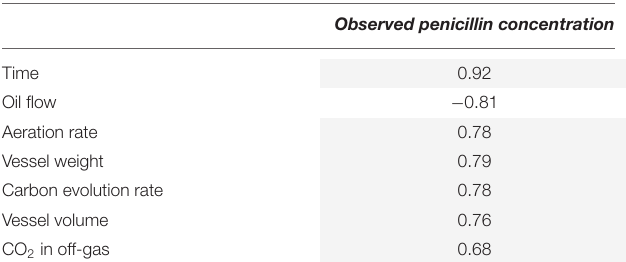
TABLE 4 | Correlation table between the parameters of the bioreactor and the observed penicillin concentration for Dataset 3 .